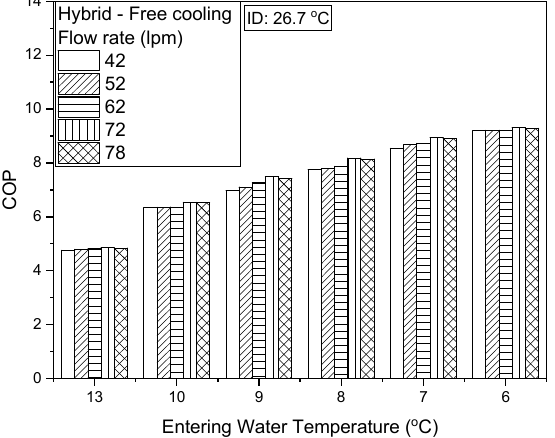
Figure 14. COP according to secondary fluid flow rate and OD air variation.